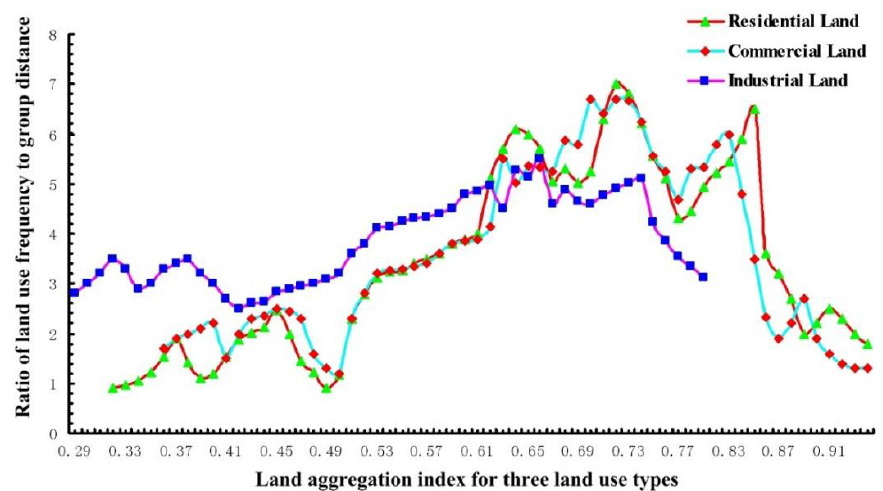
Figure 3. The frequency histogram of the Voronoi polygon aggregation index. Table 3. Statistical analysis of the Voronoi polygon aggregation index for each land use type.